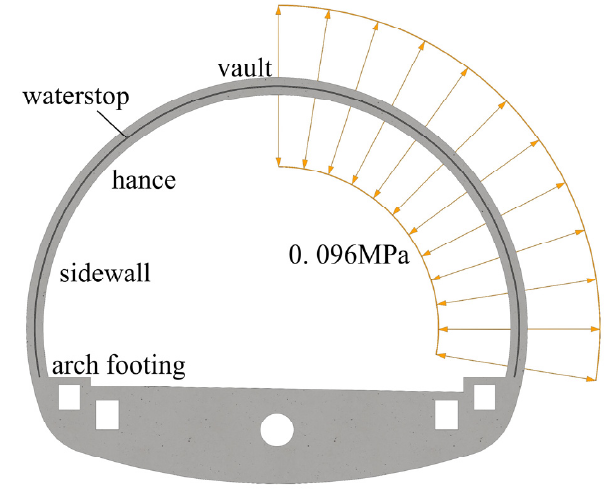
Figure 14. The adhesive force of the waterstop.